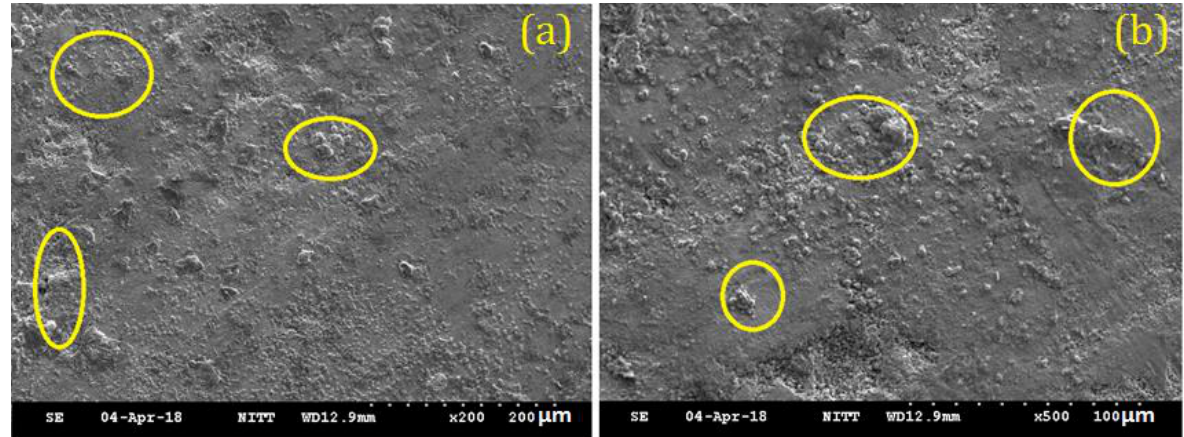
Figure 2. SEM image of the biodegradable zinc alloy ( a ) 200 µm and ( b ) 100 µm.